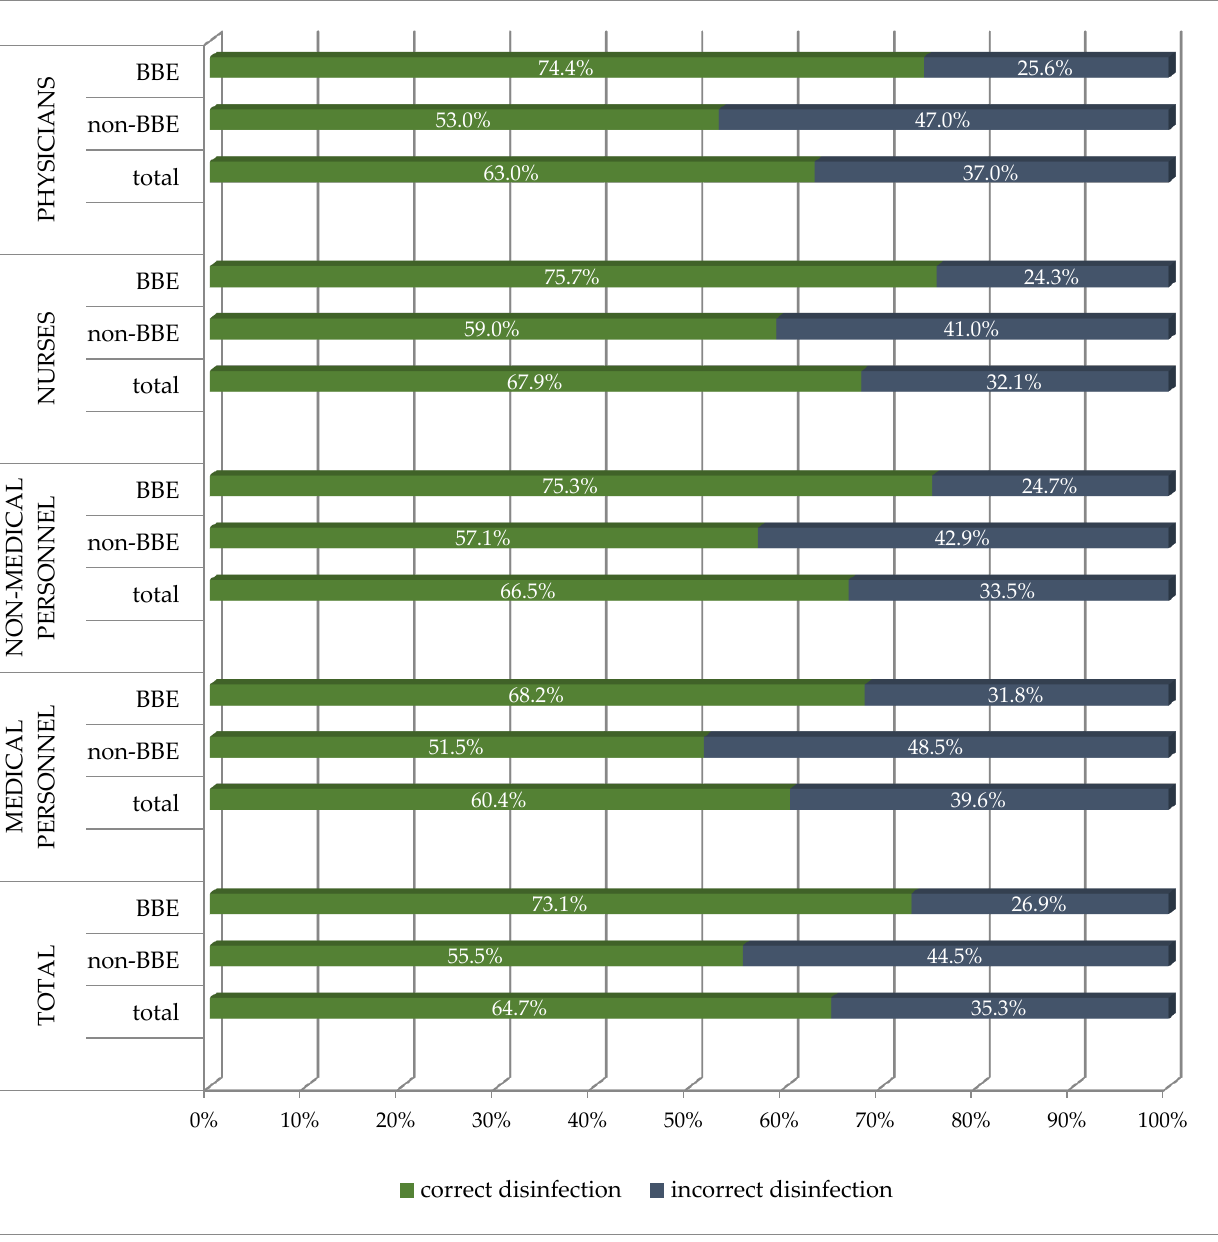
Figure 4. The frequency of hand disinfection in various professional groups, depending on the adherence to BBE compliance.